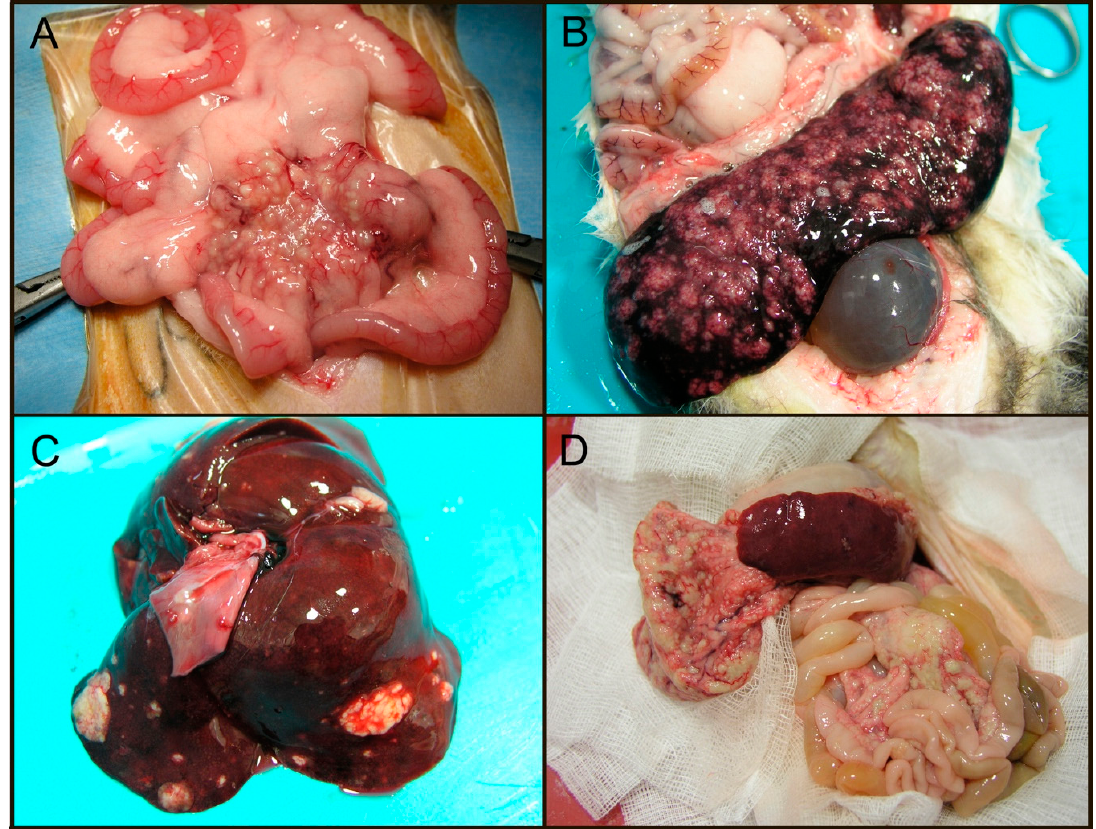
Figure 4. Gross lesions associated with ferret systemic coronavirus (FRSCV). ( A ) Ferret, coronavirus- associated granulomatous mesenteritis. Numerous, multifocal to coalescing, pale tan, firm nodular masses (granulomas) distributed throughout the mesentery, often corresponding to vasculature. ( B ) Ferret, coronavirus-associated serositis and splenitis. Numerous, multifocal to coalescing, pale tan nodules (granulomas) expanding the serosa with variable parenchymal involvement. ( C ) Ferret, coronavirus-associated hepatitis. Multifocal, pale tan, expansile nodular masses throughout the